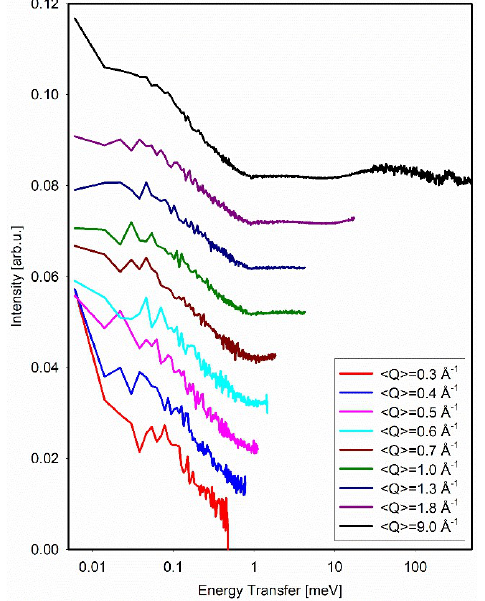
Fig. 3 . HIV-1 protease at 120 K, measured at BWAVES using the default  f = 14.50 Å for 5 hours (virtually). The nine average <Q> values refer to the Q- bins of 0.25-0.35 Å -1 , 0.35-0.45 Å -1 , 0.45-0.55 Å -1 , 0.55-0.65 Å -1 , 0.65-0.75 Å -1 , 0.75-1.25 Å -1 , 0.75-1.85 Å -1 , 0.75-2.85 Å -1 , and 0.15-17.85 Å -1 Fig. 3 illustrates the output of a virtual BWAVES experiment to measure dynamics of HIV-1 protease.